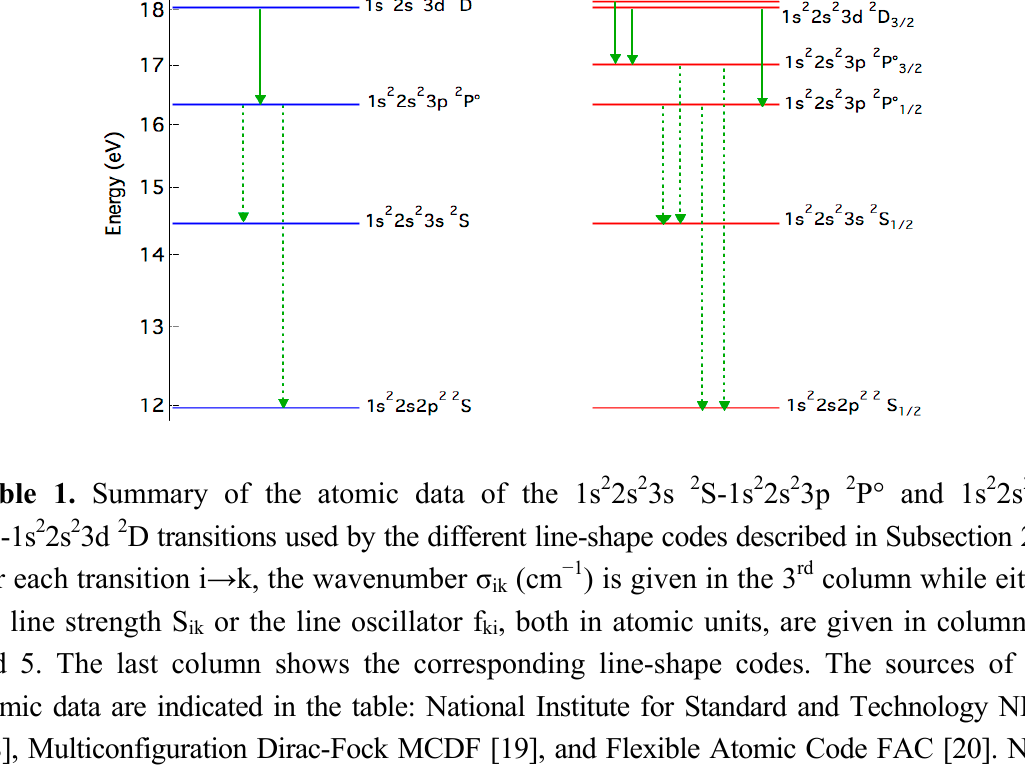
Figure 2. Schematic energy diagrams of the radiator considered for the present study without ( a ) and with ( b ) the fine structure effect. Energy splitting between the 1s 2 2s 2 3p 2 P° and 1s 2 2s 2 3d 2 D doublets is exaggerated (magnified by a factor of 500) for both of levels. Arrows represent radiative dipolar transitions with solid ones representing those transitions considered for the present study.